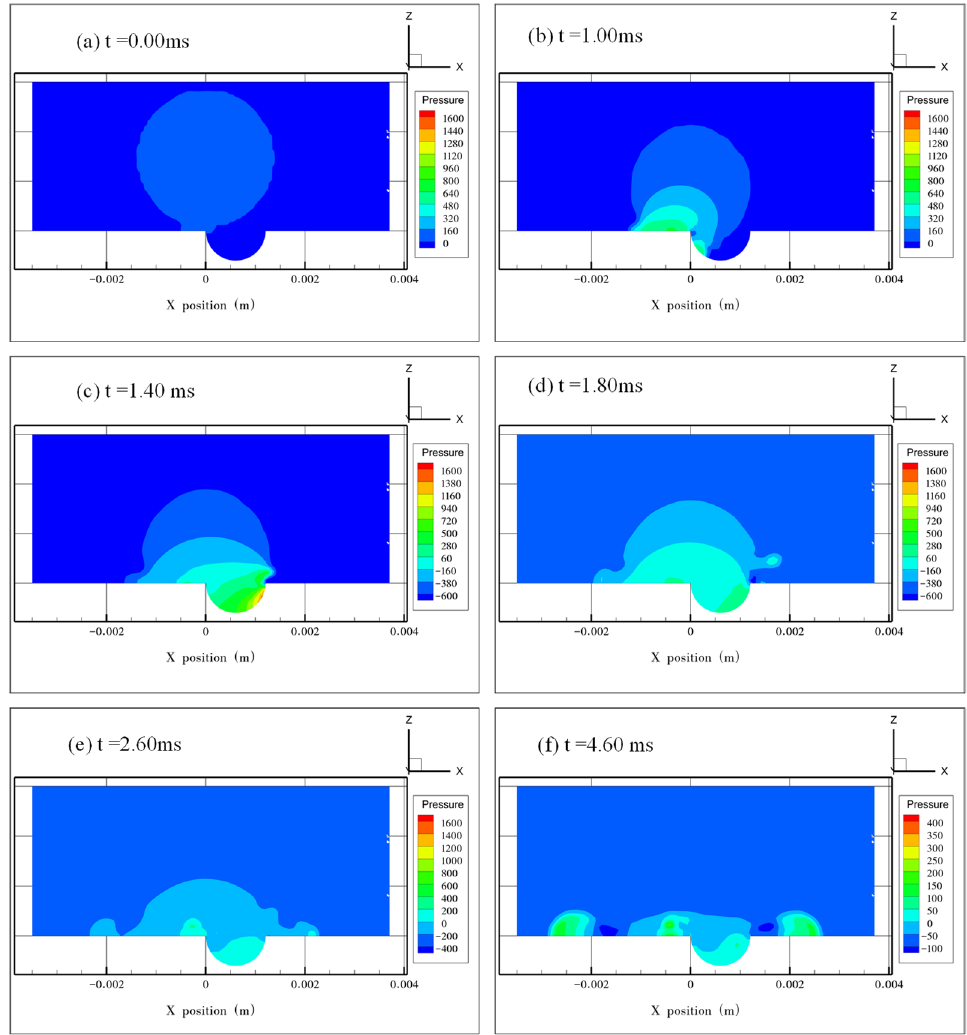
Figure 10. Pressure distribution inside the droplet at e = 0.50. ( a ) The initial pressure distribution when the droplet starts to impact the surface at t = 0.00 ms. ( b – e ) The maximum pressure moves from the left side to the right side of the dimple along with droplet spreading. In ( d ), the highest pressure (about 60 Pa) occurs in the tip of the jetting finger. ( f ) Pressure distribution when the droplet spreads to its maximum diameter.